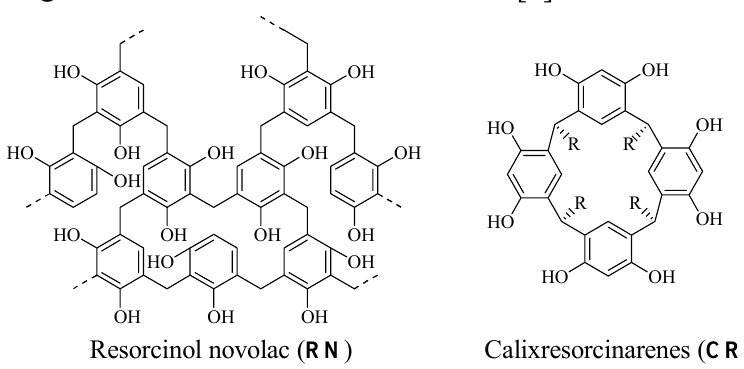
Figure 1 . Resorcinol novolac and